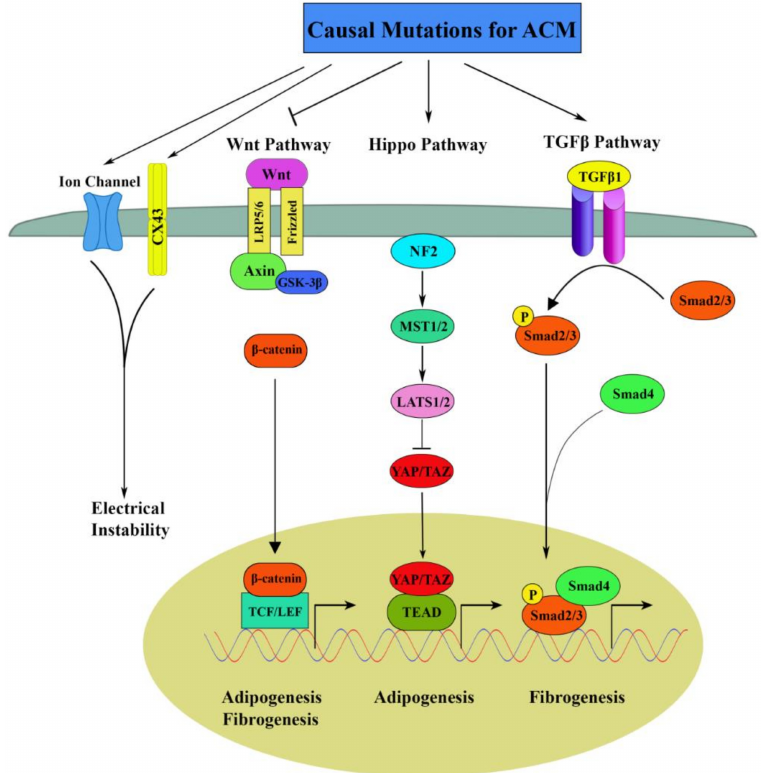
Figure 2. Molecular pathogenic signaling pathways in ACM. Mutations in genes encoding desmosomal components cause Hippo pathway activation, Wnt inhibition and enhanced adipogenesis in ACM. Moreover, the canonical TGF β pathway contributes to increased fibrosis in ACM through activation of SMADs and JNK, respectively. Furthermore, mutations in desmosome genes destabilize the intercalated disks causing dysfunction of ion channels with consequent electrical instability, a prominent phenotype in the early stages of ACM. ACM: arrhythmogenic cardiomyopathy; Cx43: connexin 43; Wnt: wingless-Int; LRP)5 / 6: lipoprotein receptor-related protein; GSK-3 β : glycogen synthase kinase-3 β ; TCF / LEF: T-cell factor / lymphoid enhancing factor; NF2: neurofibromin 2; MST1 / 2: mammalian Sterile 20-related 1 and 2; LATS1 / 2: arge tumor suppressor 1 and 2; YAP: Yes associated protein; TAZ: transcriptional co-activator with PDZ-binding motif; TAED: TEA domain; TGF- β : transforming growth factor-beta; Smad: small mother against